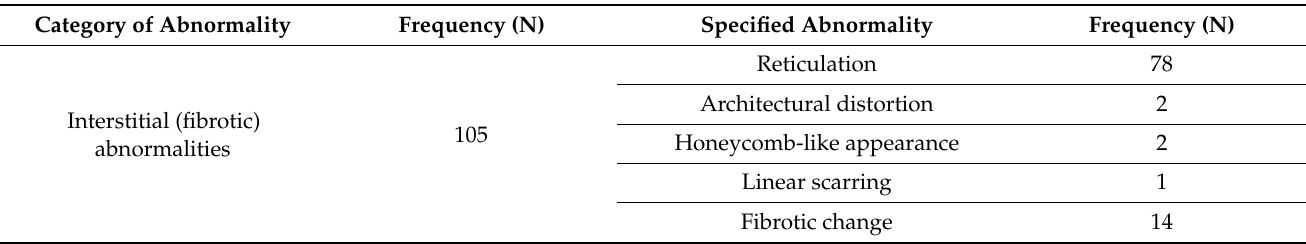
Table 2. Frequency of radiological findings in long COVID patients and their